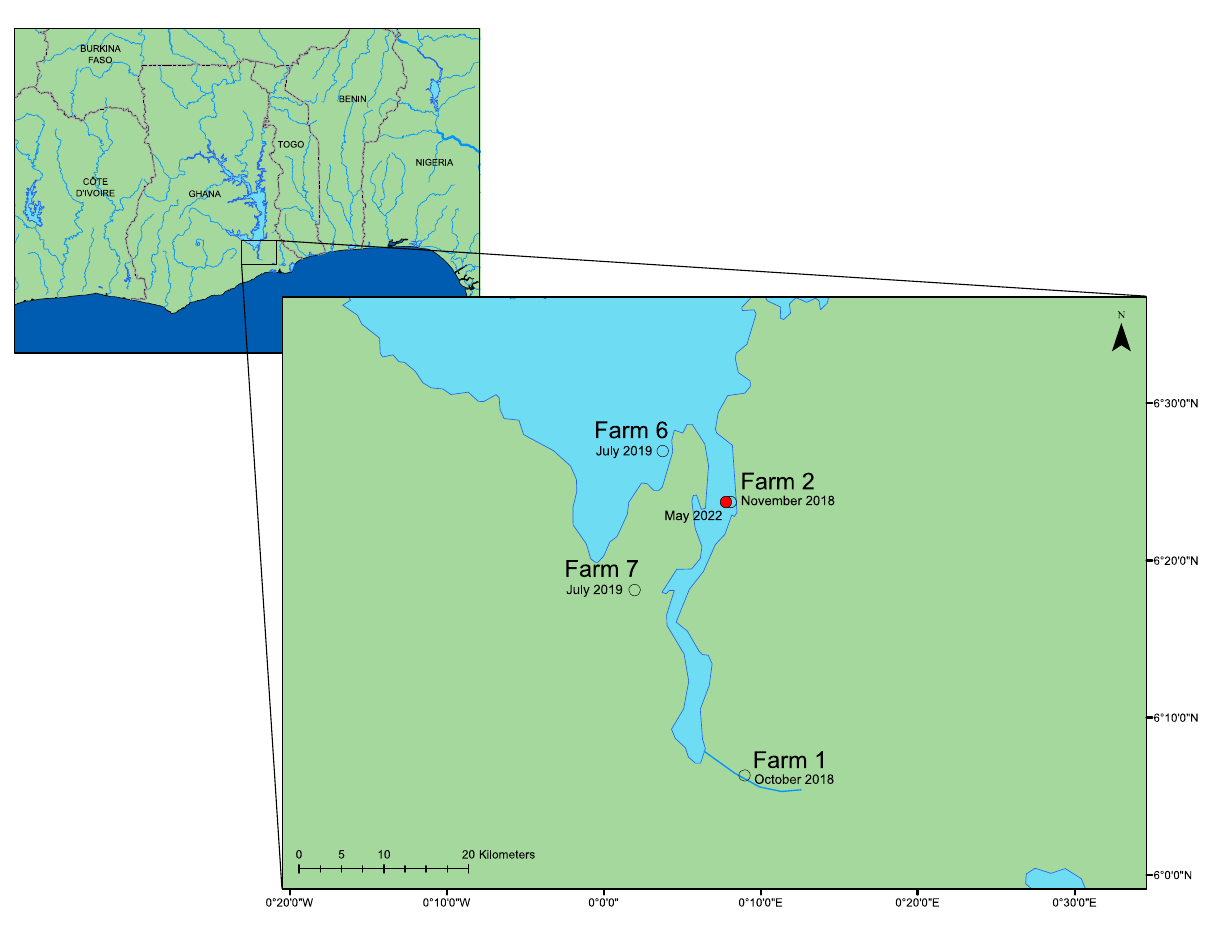
Figure 1. A map of the lower region of Lake Volta in Ghana, West Africa, showing the date and location of the farms where the outbreaks of mortality occurred, adapted from [11]. This map was constructed using ArcGIS (GIS software). Version 10.0. Redlands, CA, USA: Environ-mental Systems Research Institute, Inc., 2010.